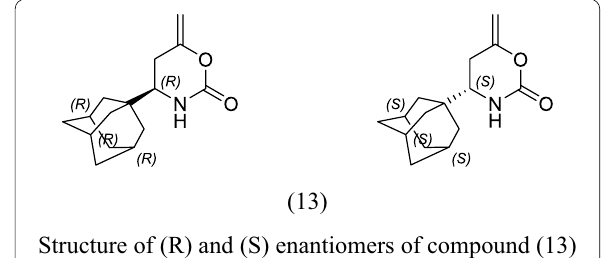
(Fig. 18) demonstrated highest cytotoxic effect against MDA-MB-231 breast cancer cell lines [32].